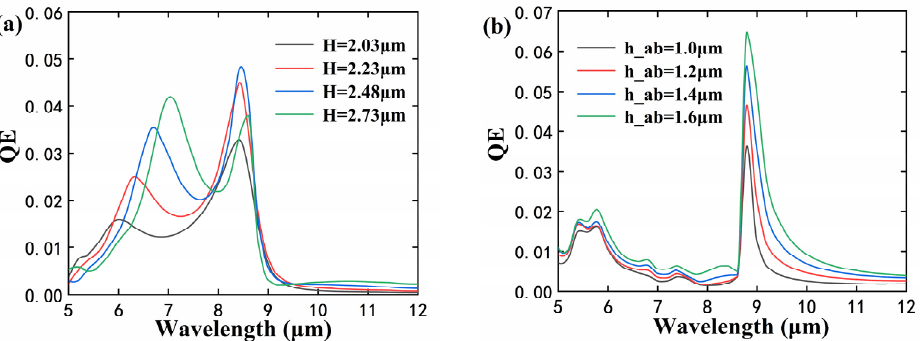
Figure 3. ( a ) QE as a function of incident wavelength at different micropillar heights. h_n1 and h_n2 remain constant at 1.1 μ m and 0.13 μ m, respectively. The micropillar height (H) changes with h_ab. ( b ) QE as a function of incident wavelength at different h_ab. The micropillar height (H) remains constant at 4 μ m, only h_ab changes.